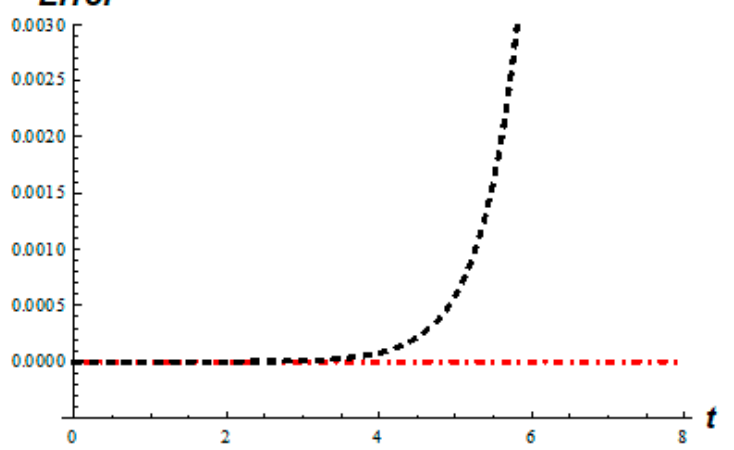
Figure 2. The absolute errors corresponding to approximate solutions using the MDM (red dash- dotted line) and RK4 method (black dashed line) for 0 8 t ≤ ≤ and 0.1 h = .